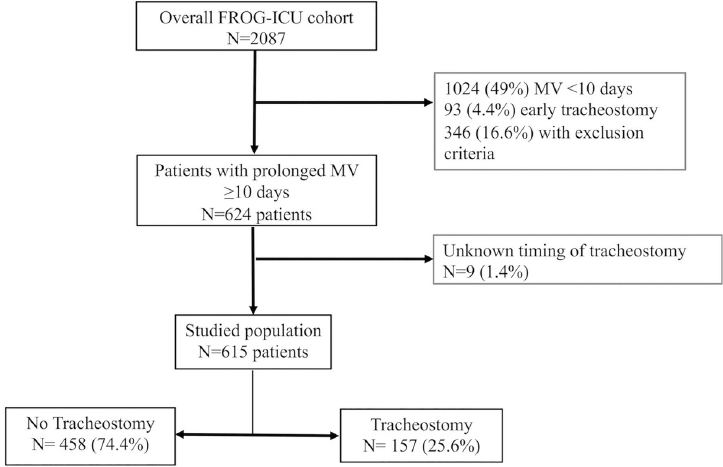
Fig 1. Flowchart of the study. Flowchart of patients with prolonged mechanical ventilation ( � 10 days), with or without tracheostomy, included in the FROG-ICU sub-study.